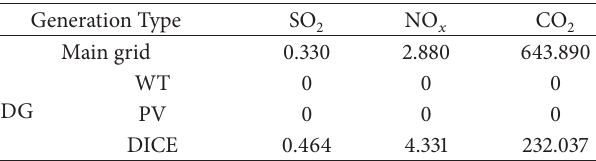
shown in Figure 6.